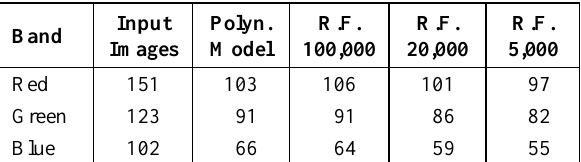
Table 1. Comparison of RMS DN differences at radiometric tie points before and after radiometric normalization adjustment with different approaches: polynomial model (Gehrke, 2010) vs.